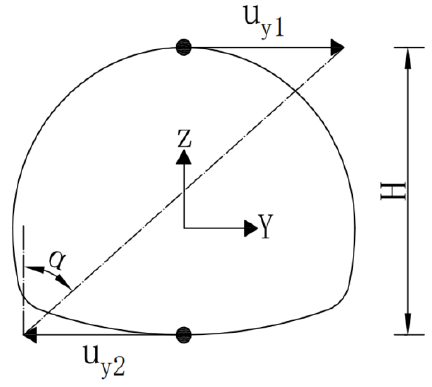
Figure 16. Diagram of the existing tunnel rotation angle.